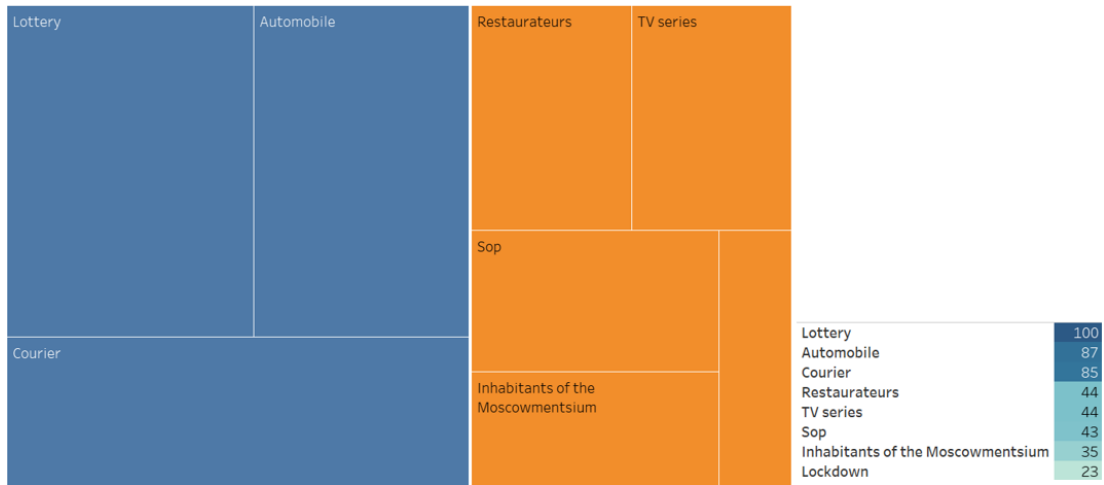
Figure 12. Associative network of the “Vaccination prize drawing” stimulus in the negative